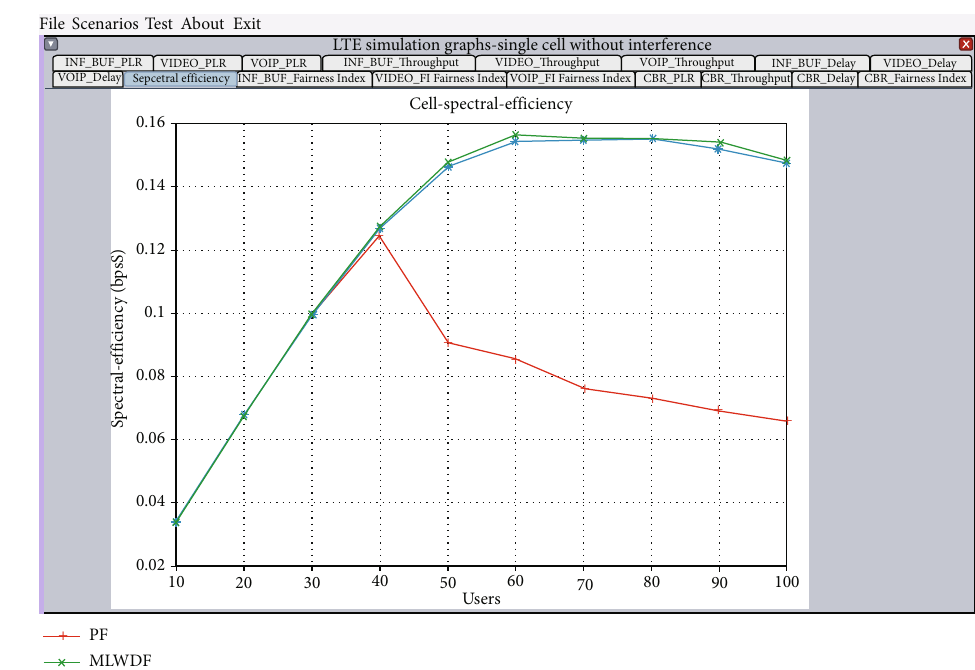
Figure 11: System packet delay vs. number of users.